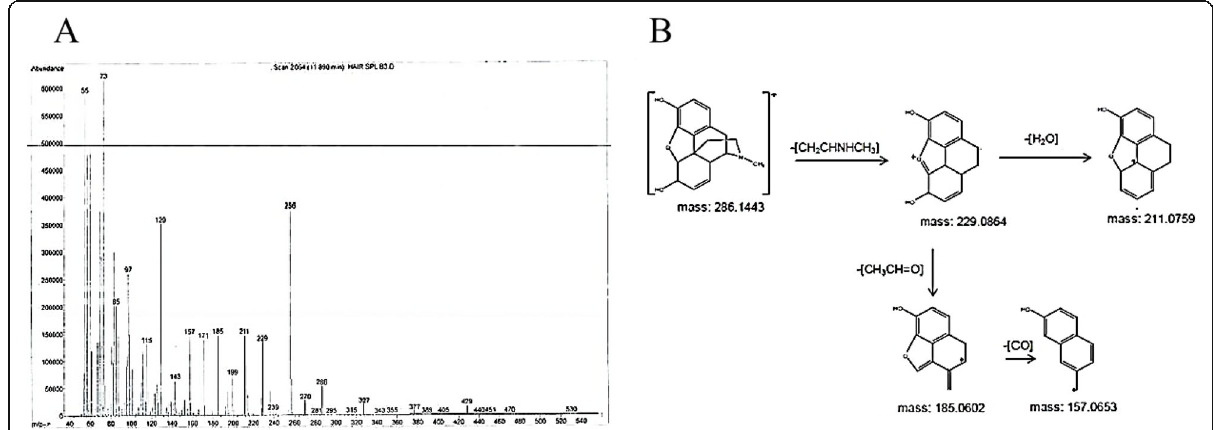
Fig. 1 Sample analysis taken from regular random addicts ’ group. a Mass spectrum of the regular addict sample. b Fragmentation pathway